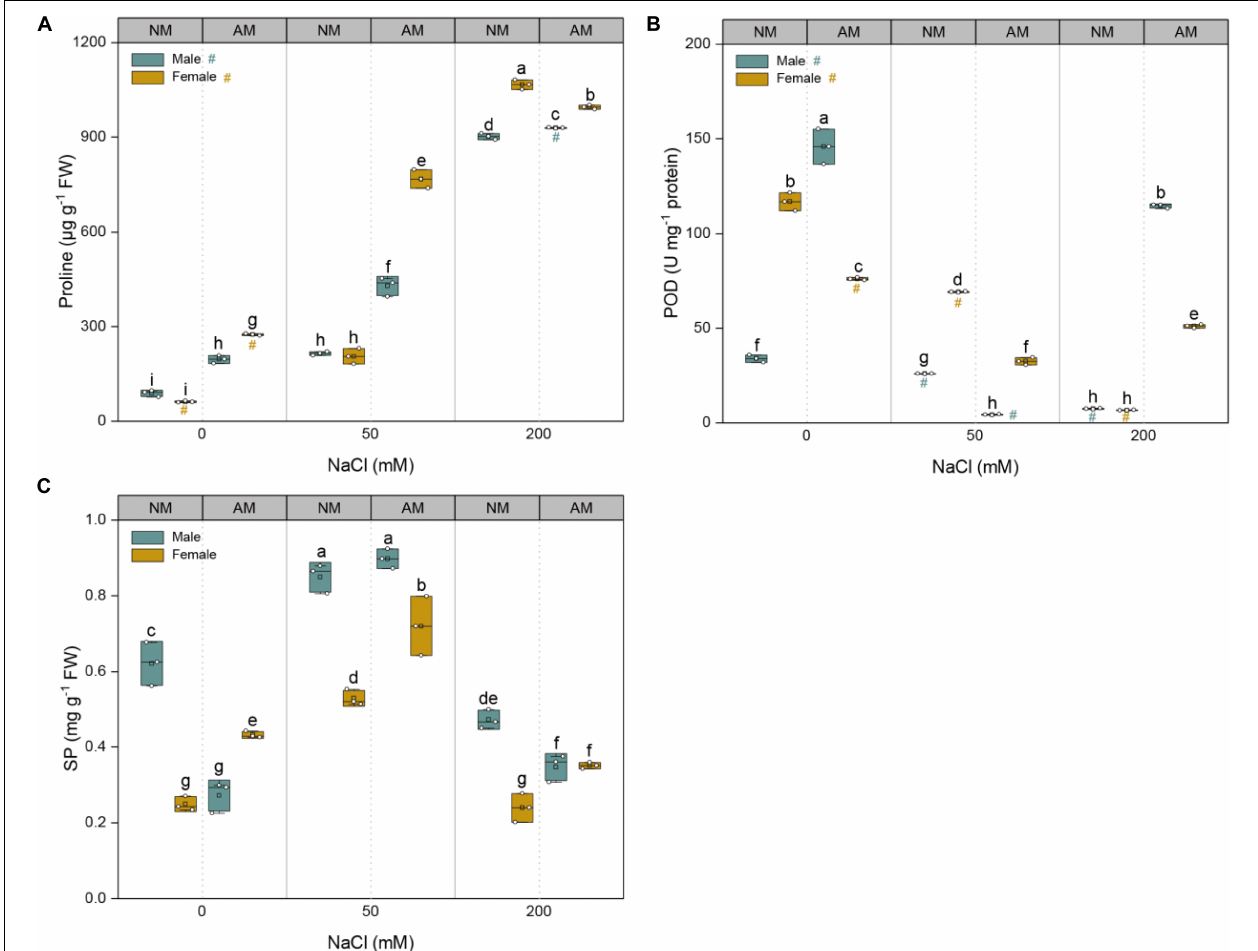
FIGURE 4 | Effects of arbuscular mycorrhizal fungus on proline concentrations (A) , peroxidase (B) , and soluble protein (SP) (C) in males and females of Morus alba under saline conditions. NM and AM represent inoculation with no mycorrhizal fungi and with Funneliformis mosseae , respectively. Values are presented as means ± SD ( n = 3). Three-way ANOVA is performed to compare the effects of sex, salt, and AM inoculation and their interactions in both males and females. Different letters indicate a significant difference according to least significant difference at p <